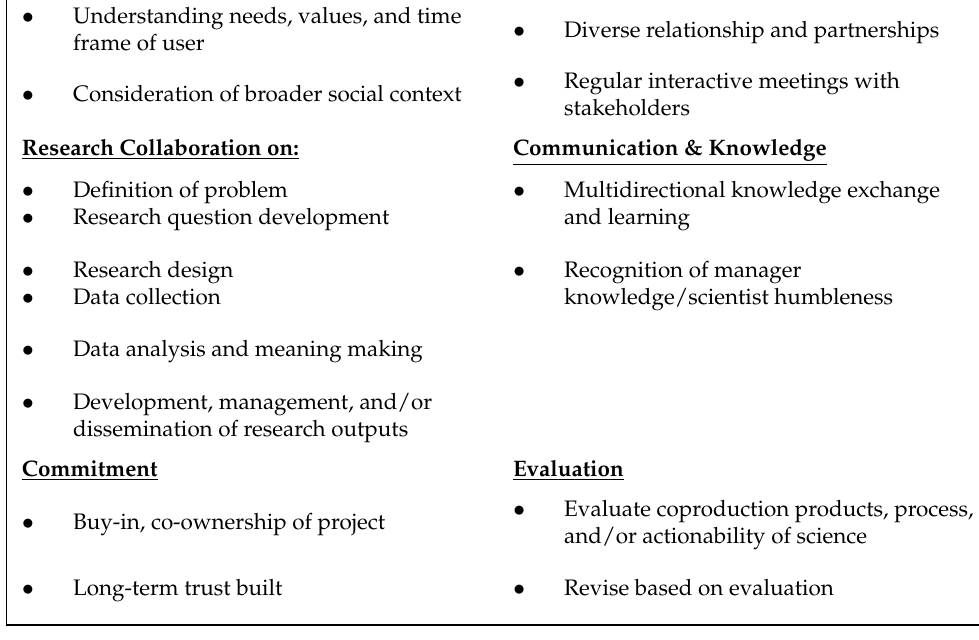
Table 1. Knowledge coproduction categories and activities—a priori codes. Categories are bolded and activities within the category are bulleted. A priori codes are a combination of categories and elements (e.g., Research Collaboration on: Research